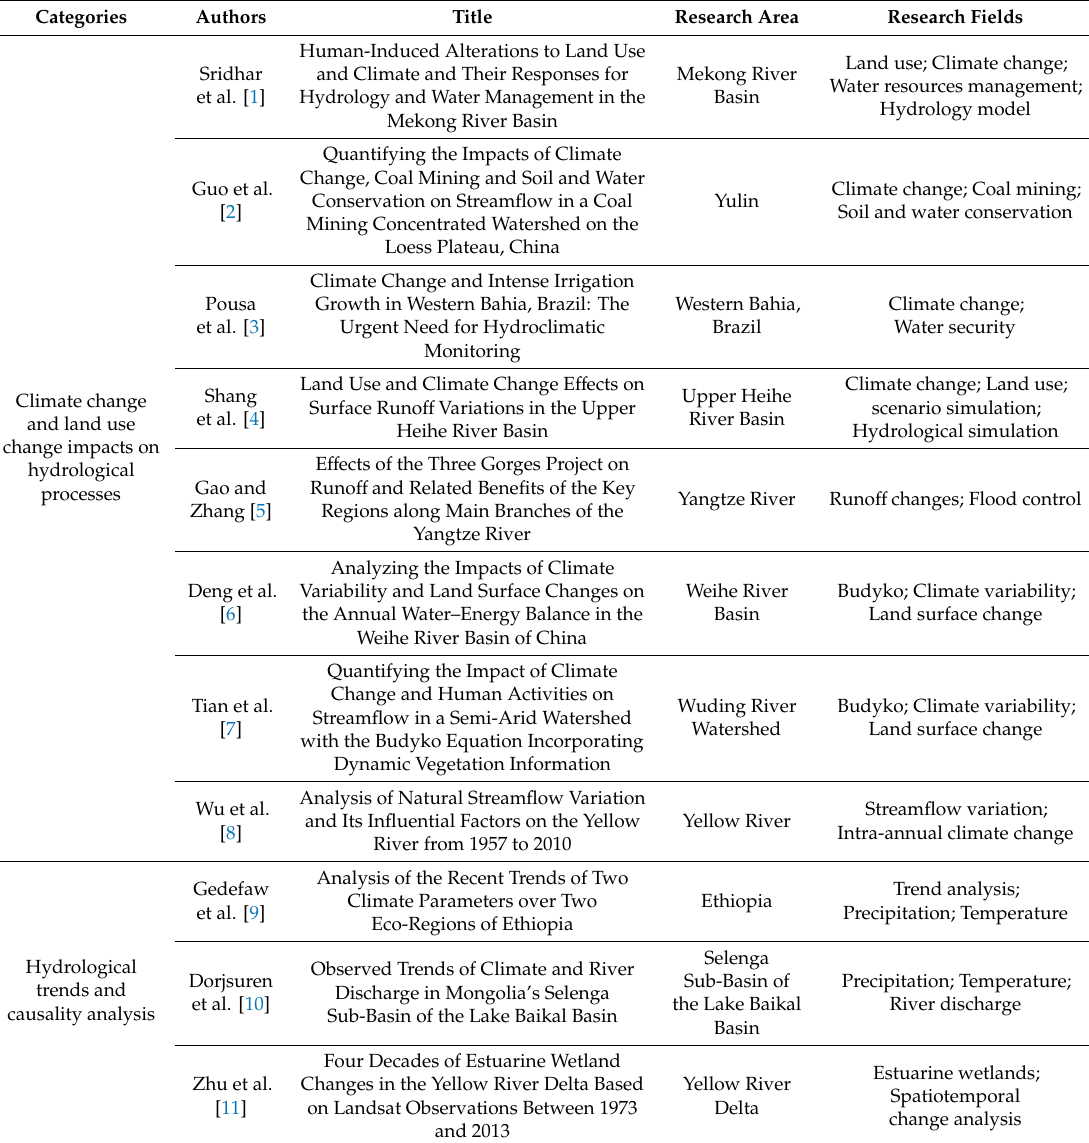
Table 1. Summary of 24 papers published in the special issue “Climate Variability and Climate Change Impacts on Land Surface, Hydrological Processes and Water Management” in Water